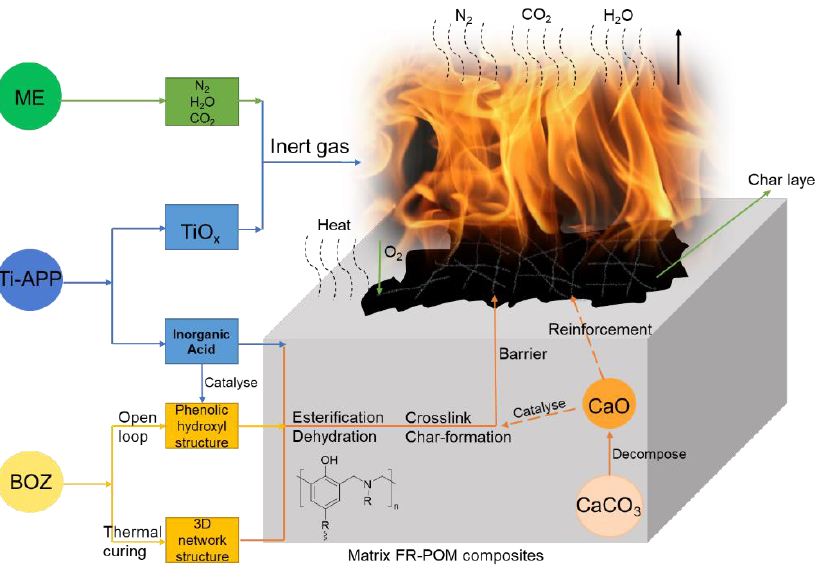
Figure 16. Schematic diagram of flame retardancy mechanism of FR-POM.